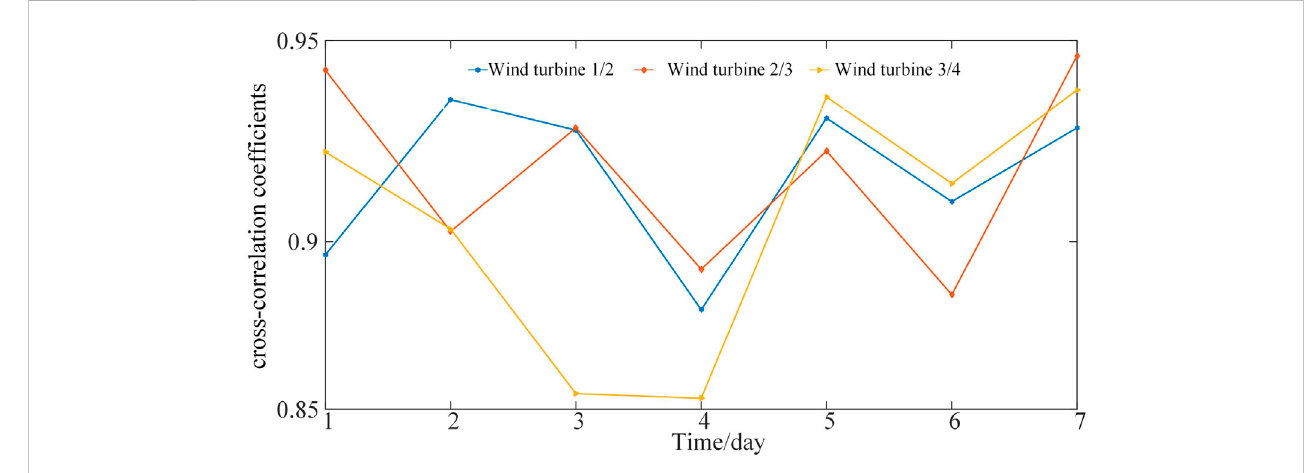
FIGURE 5 Output cross-correlation coef fi cients of adjacent wind